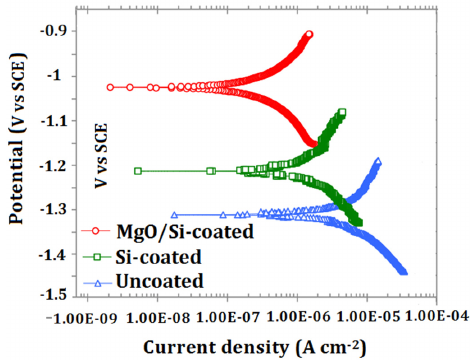
Figure 8. Potentiodynamic polarization curves of uncoated, MgO ‐ coated and Si/MgO ‐ coated in simulated body fluid (SBF) solution.